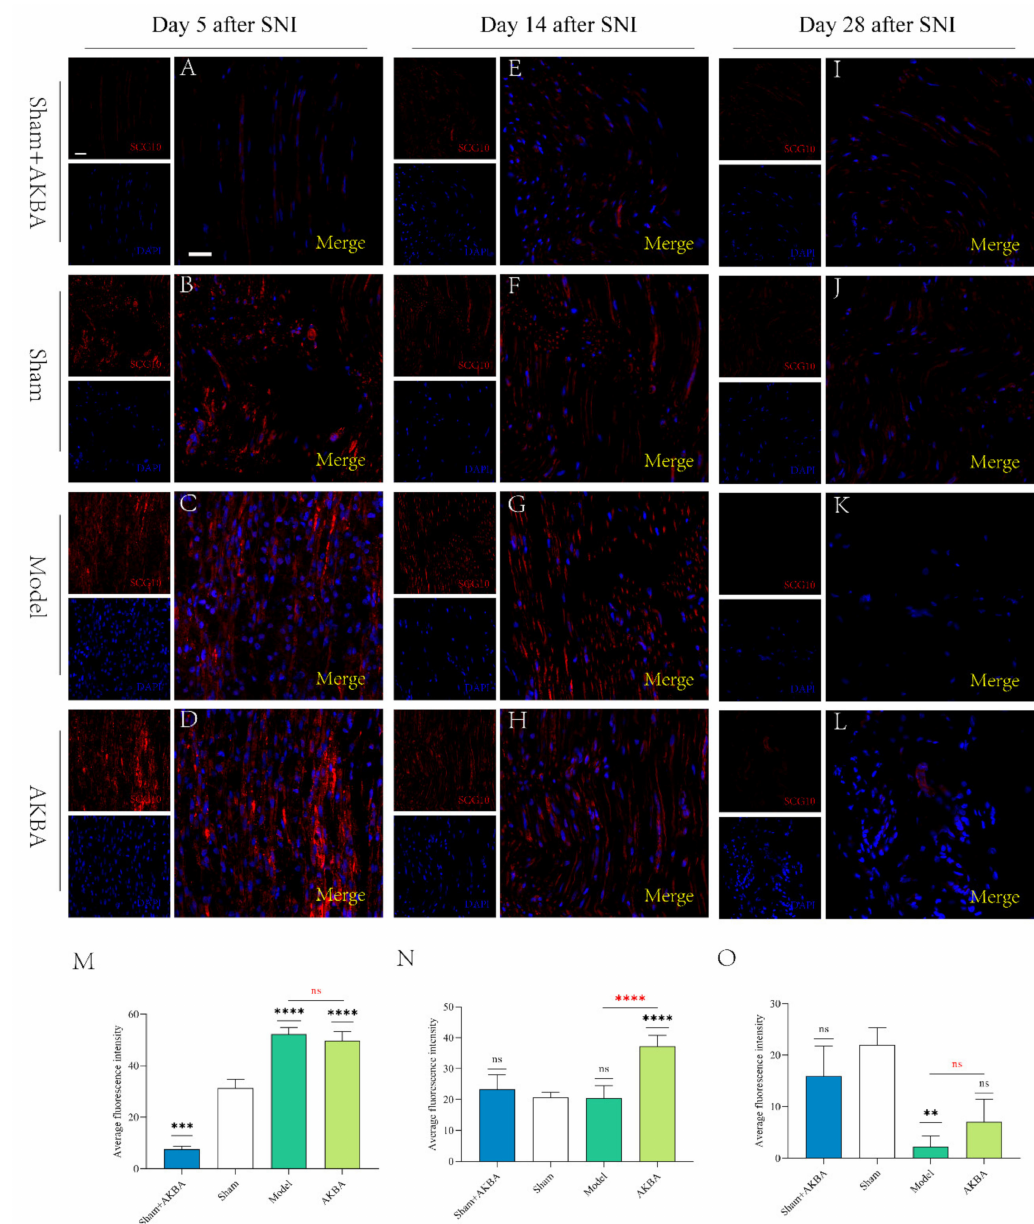
Figure 3. SCG10 staining at various time points after sciatic nerve injury. ( A – D ) Immunofluorescence of SCG10 d 5 after sciatic nerve injury. ( E – H ) Immunofluorescence of SCG10 d 14 after sciatic nerve injury. ( I – L ) Immunofluorescence of SCG10 d 28 after sciatic nerve injury. ( M – O ) Quantification of mean fluorescence of SCG10 immunofluorescence 5 d, 14 d, and 28 d after sciatic nerve injury. Black * is the comparison with the Sham group, and red * is the comparison of the Model group with the AKBA group. ** p < 0.01, *** p < 0.001, **** p < 0.0001; ns: no significant difference. The subsequent images are labeled similarly. The scale bar of all images is 20 µ